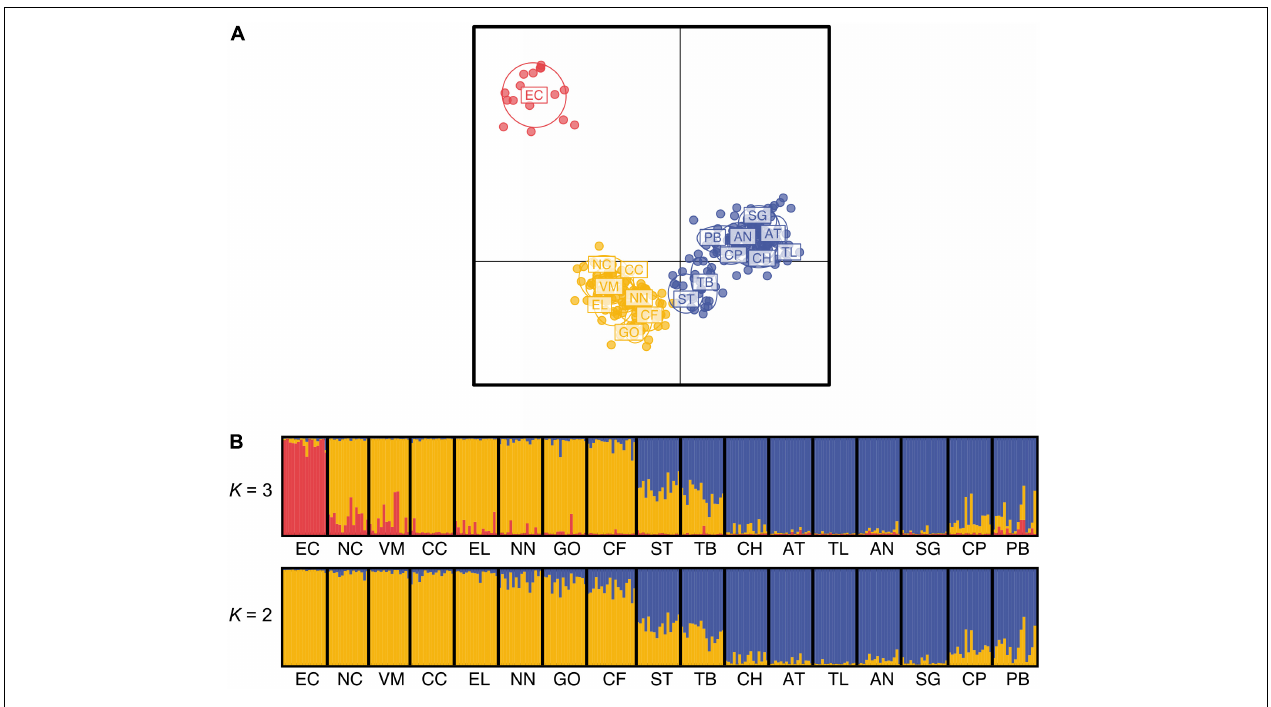
FIGURE 4 | Population structure results from the neutral SNP data set. (A) Scatter plot from the discriminant analysis of principal components (DAPC) with 80 principal components retained on the first two Discriminant Analysis axes showing the differentiation between the three groups and inertia ellipses. Each color represents a cluster as identified with the Bayesian Information Criterion (BIC). Red dots represent individuals from the Eagle Creek (EC) population, yellow dots represent individuals from the population south of treeline except for EC (South), and blue dots represent individuals from populations north of treeline (North). (B) Bar graph of STRUCTURE results for population structure analysis. Each vertical bar represents an individual, and colors show the proportion of ancestry assigned to each of the three clusters ( K = 2 and K = 3), as inferred from (cid:49) K values. Eriophorum vaginatum populations are ordered from south to north location along the latitudinal gradient in north central Alaska. See Table 1 for collection site